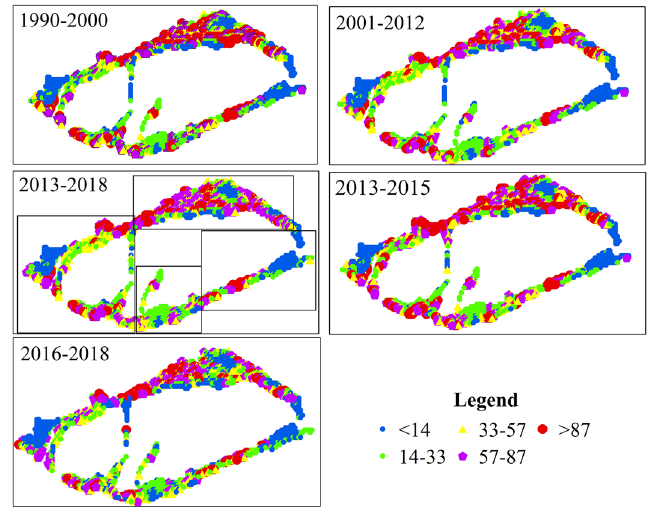
Figure 4. The spatial variation of NPP in the different time